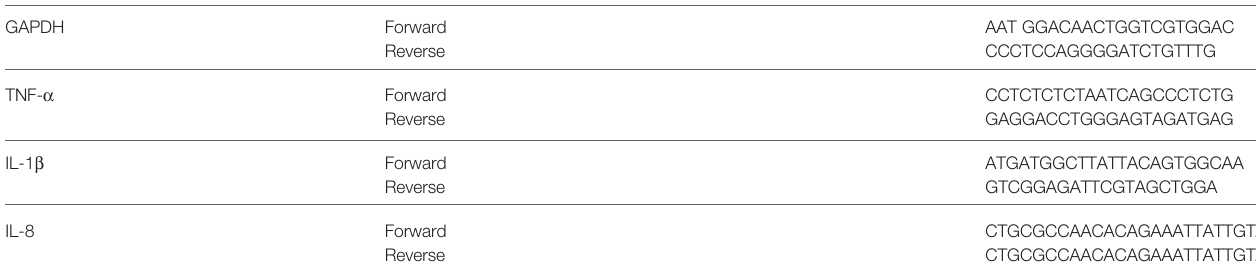
TABLE 1 | Sequences of RT-PCR primers.